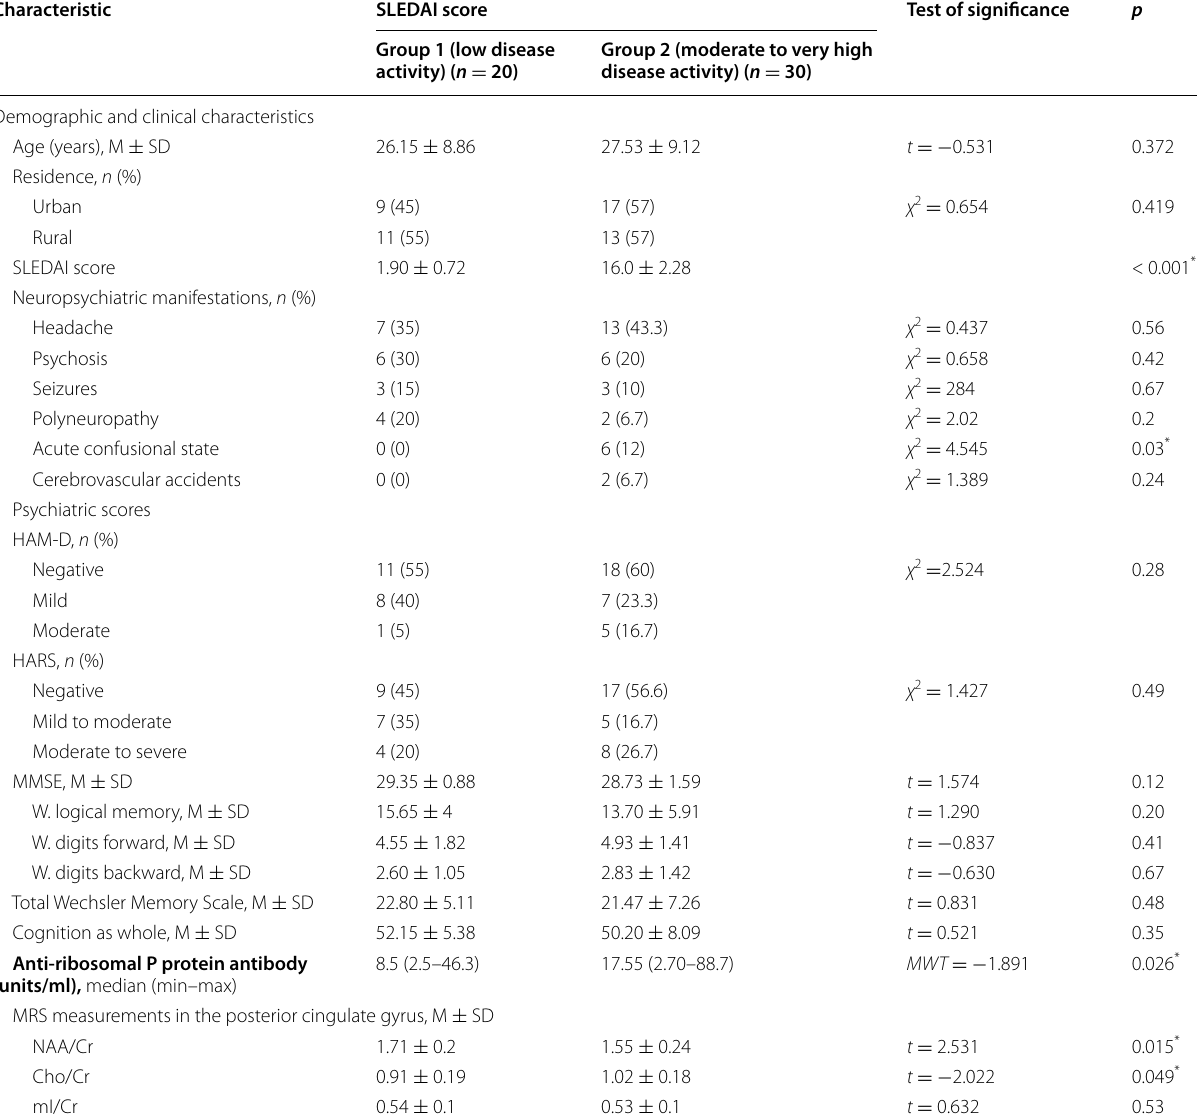
Table 3 Comparison between patients with inactive versus patients with active lupus disease regarding clinical, serological, and brain MRS measurements in the posterior cingulate